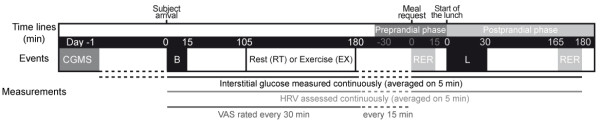
Schedule of experimental events for each subject. The experimental procedure was conducted on 3 successive days with rest (RT) and exercise (EX) as conditions tested in counterbalanced order across subjects (D1 and D3) and separated by a washout day (D2). CGMS, continuous glucose monitoring system; B, breakfast; VAS, visual analogue scales; HRV, heart rate variability; L, freely requested lunch; RER, respiratory exchange ratio.